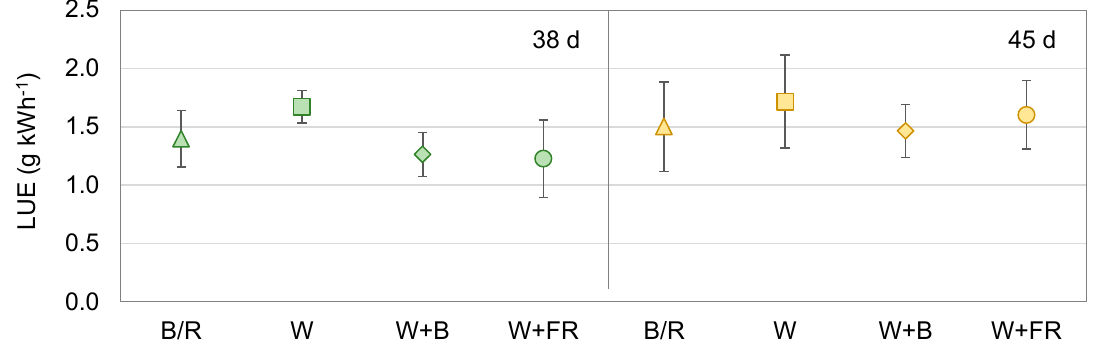
Figure 8. Light use efficiency (LUE) for marjoram plants grown under light treatments with blue and red as standard compared to white light with different shares of blue, green, and far red ( n = 9). Results are shown for a cultivation time of 38 d and 45 d, respectively.